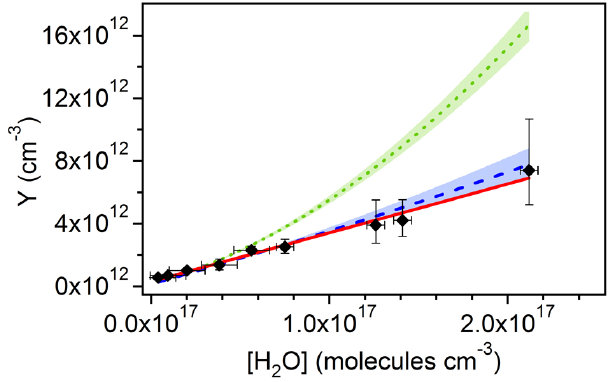
Figure 4. Application of Eq. (5) to derive relative rate constants for reaction of the sum of the MVKOO and MACROO SCI (CRB- SCI) with the water monomer, and the decomposition rate. Red line: water-monomer-only reactions; blue dashed line: water monomer reaction and CH 2 OO water dimer reaction rate from Newland et al. (2015); green dotted line: CH 2 OO water dimer reaction rate from Chao et al. (2015). Shaded areas indicate reported uncertainties on dimer reaction rates. Y = [SO 2 ] (( 1 /f ) − 1 ) − k 9 [acid] /k 2 .